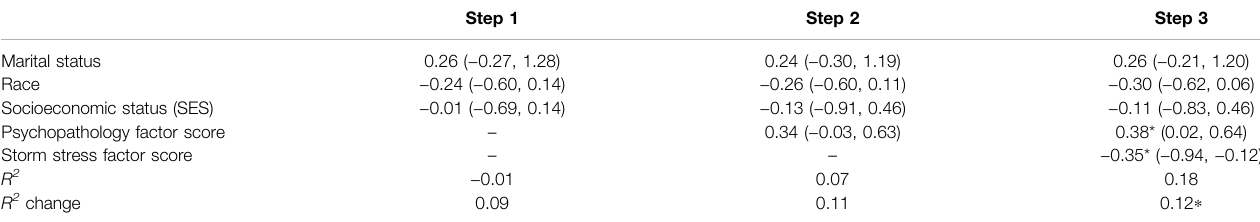
TABLE 3 | Prenatal maternal stress and psychopathology predict infant temperament.